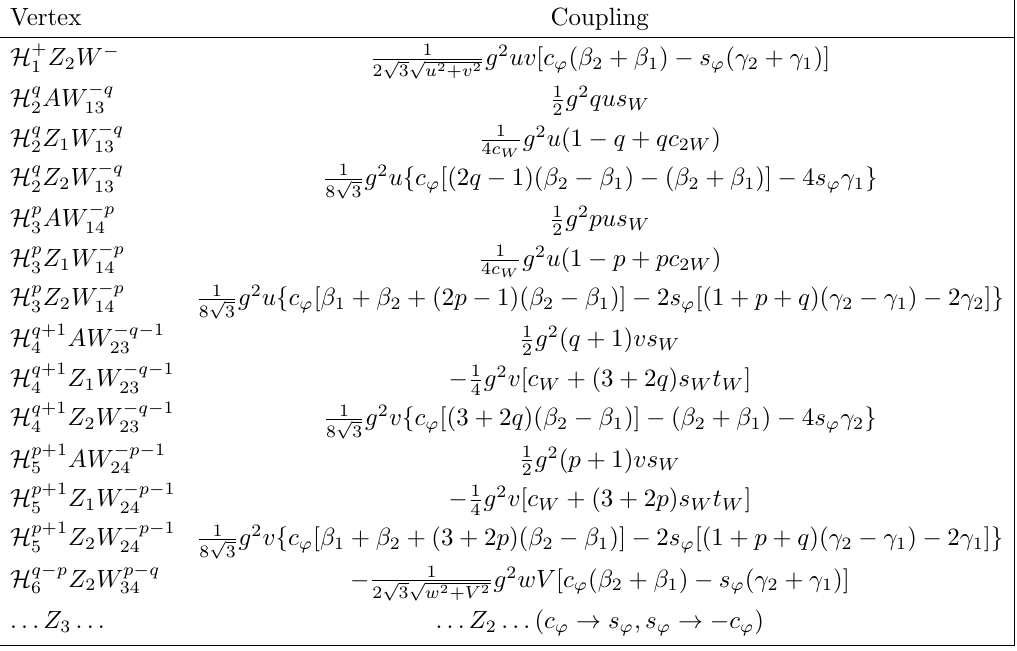
Table 10 . The interactions of a scalar with a neutral and a charged gauge boson.